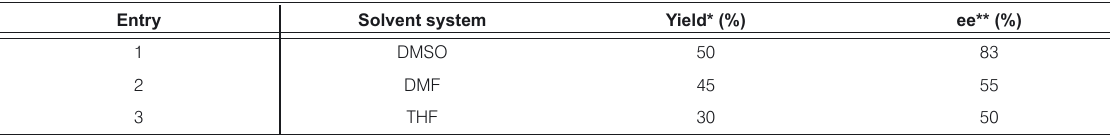
*Isolated yield after column chromatography, **Determined by